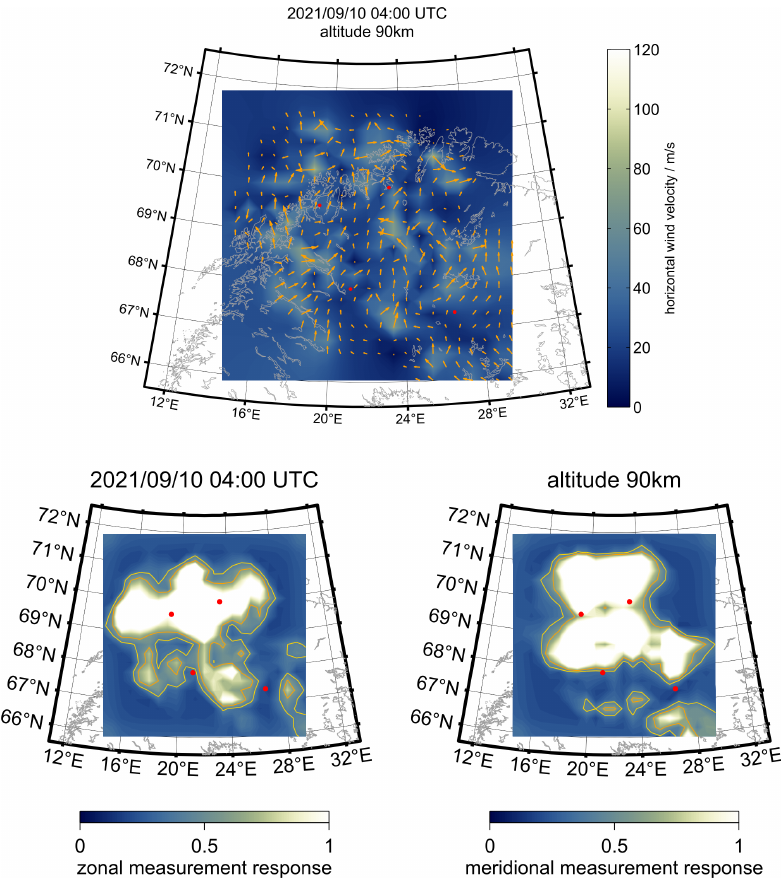
Figure 7. Snapshot of zonal and meridional winds as well as the corresponding measurement response using the 3DVAR+DIV algorithm and measurements from the Nordic Meteor Radar Cluster. The red dots label the locations of the meteor radars. The higher the measurement response, the better and brighter the colors. Bluish colors refer to long correlations, poor measurement statistics, and almost no information gain about small-scale dynamics.